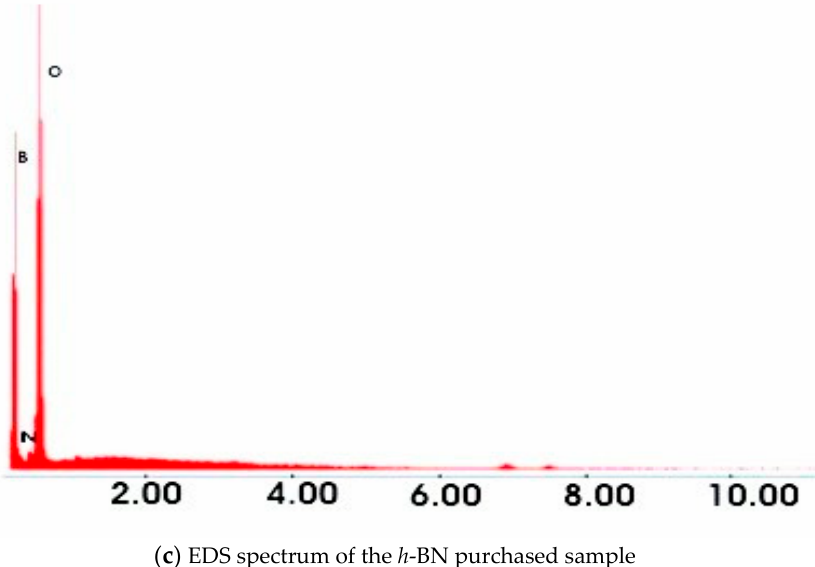
Figure 3. Different h -BN spectroscopy showing ( a ) Raman ( b ) XRD and ( c ) EDS spectroscopies.